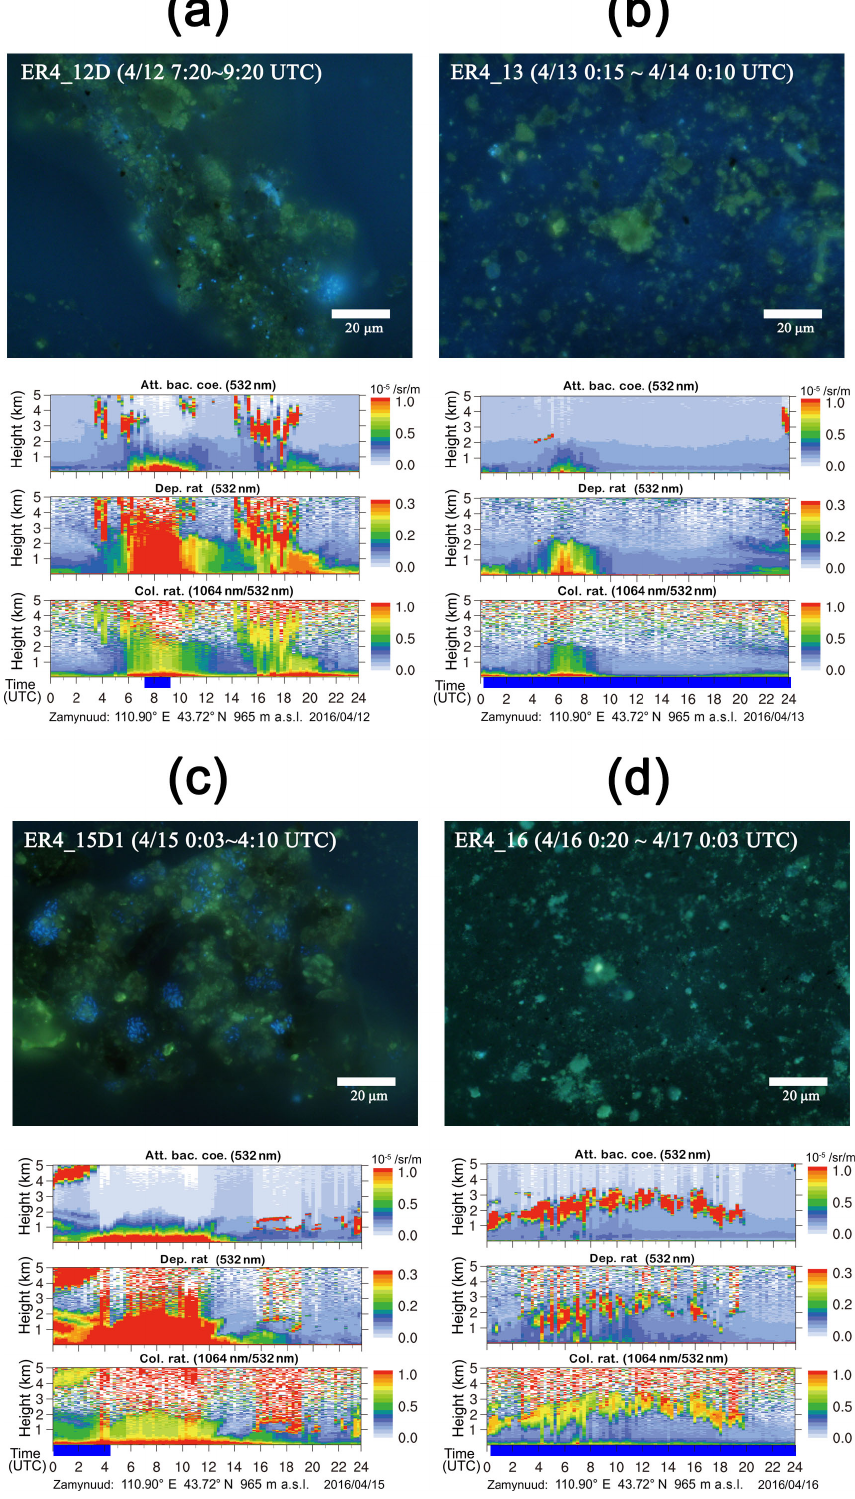
Figure 6. Comparisons of bioaerosols collected during a dust event and a non-dust event (a, b) and during a dust event that transported dust over a long distance and a local dust event (c, d) . Blue bars represent the periods over which samples were